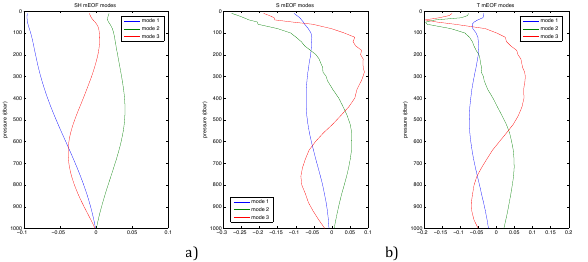
Fig. 3. First three trivariate ( T - S -SH) mEOF modes for the Gulf Stream area computed from Argo profiles (see text): (a) steric height component, (b) salinity component and (c) temperature component.